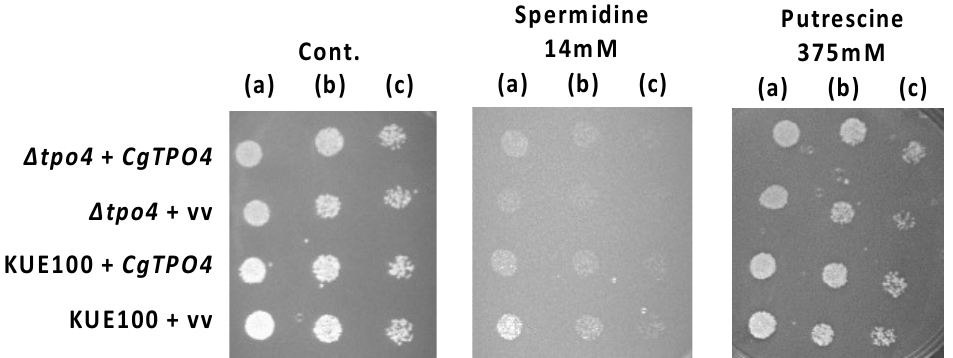
Figure 4. CgTPO4 confers resistance to polyamines in C. glabrata . Comparison of the susceptibility to the polyamines, spermidine and putrescine, at the indicated concentrations, of the C. glabrata KUE100 wild-type strain harboring the pGREG576 cloning vector (KUE100 + vv) or the pGREG576_MTI_ CgTPO4 vector (KUE100 + CgTPO4 ) and the derived KUE100_ Δcgtpo4 mutant cells harboring the pGREG576 cloning vector ( Δcgtpo4 + vv) or the pGREG576_MTI_ CgTPO4 vector ( Δcgtpo4 + CgTPO4 ), in YPD agar plates, by spot assays. The inocula were prepared as described in the Materials and Methods section. Cell suspensions used to prepare the spots were 1:5 ( b ) and 1:25 ( c ) dilutions of the cell suspension used in ( a ). The displayed images are representative of at least three independent experiments.